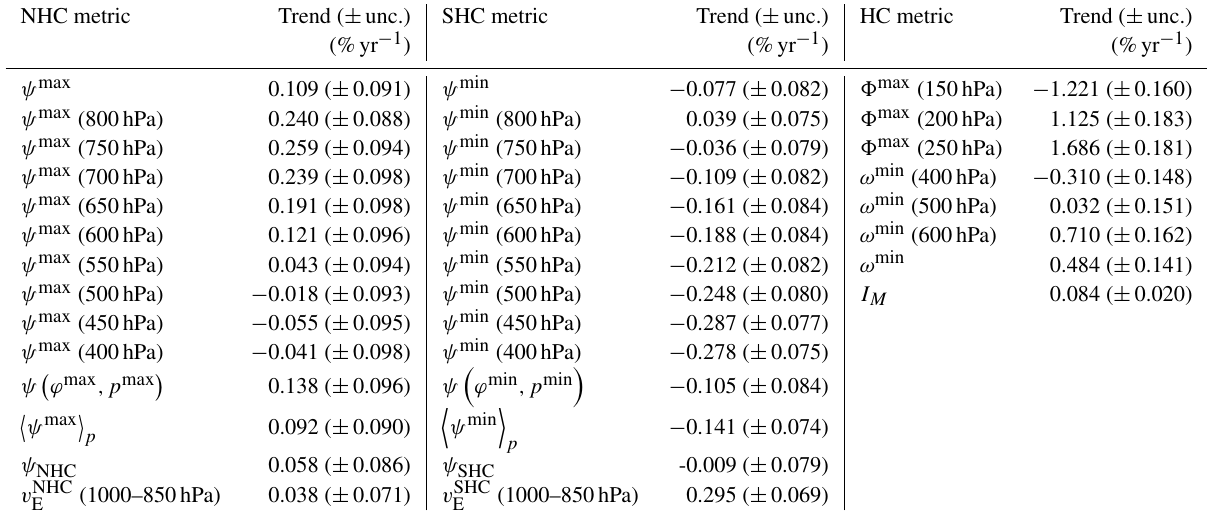
Table A1. As in Table 1, but for ERA-Interim. NHC metric Trend ( ± unc.) SHC metric Trend ( ±